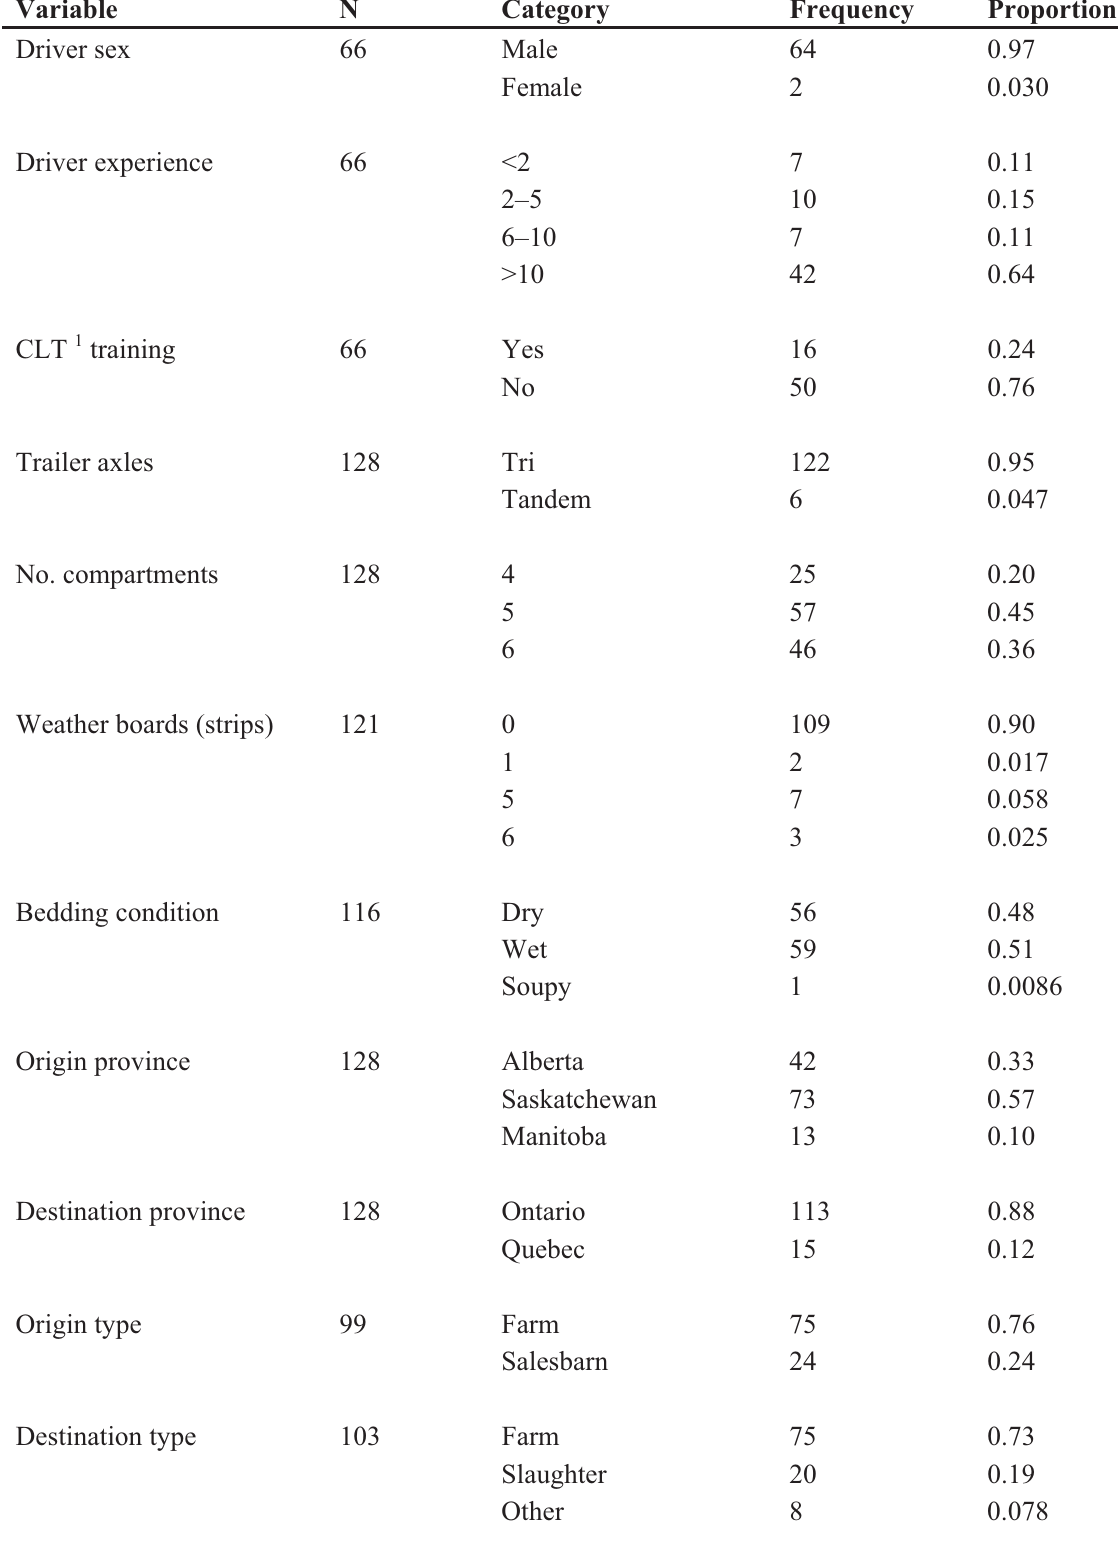
Table 3. Categorical variables collected for loads of cattle stopping for feed, water and rest near Thunder Bay,